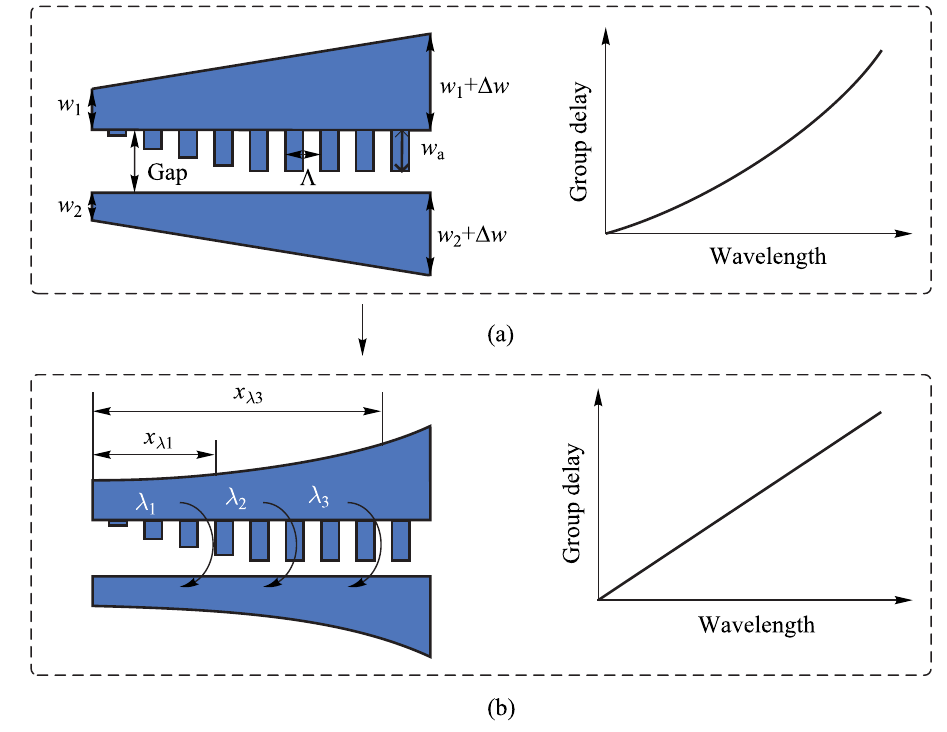
Fig. 1 Schematic diagrams of the contra-directionally coupled chirped Bragg grating waveguide and group delay spectra. a Conventional struc- ture has linearly graded waveguide width and shows a nonlinear group delay spectrum, b proposed structure has corrected graded waveguide width and shows a linear group delay